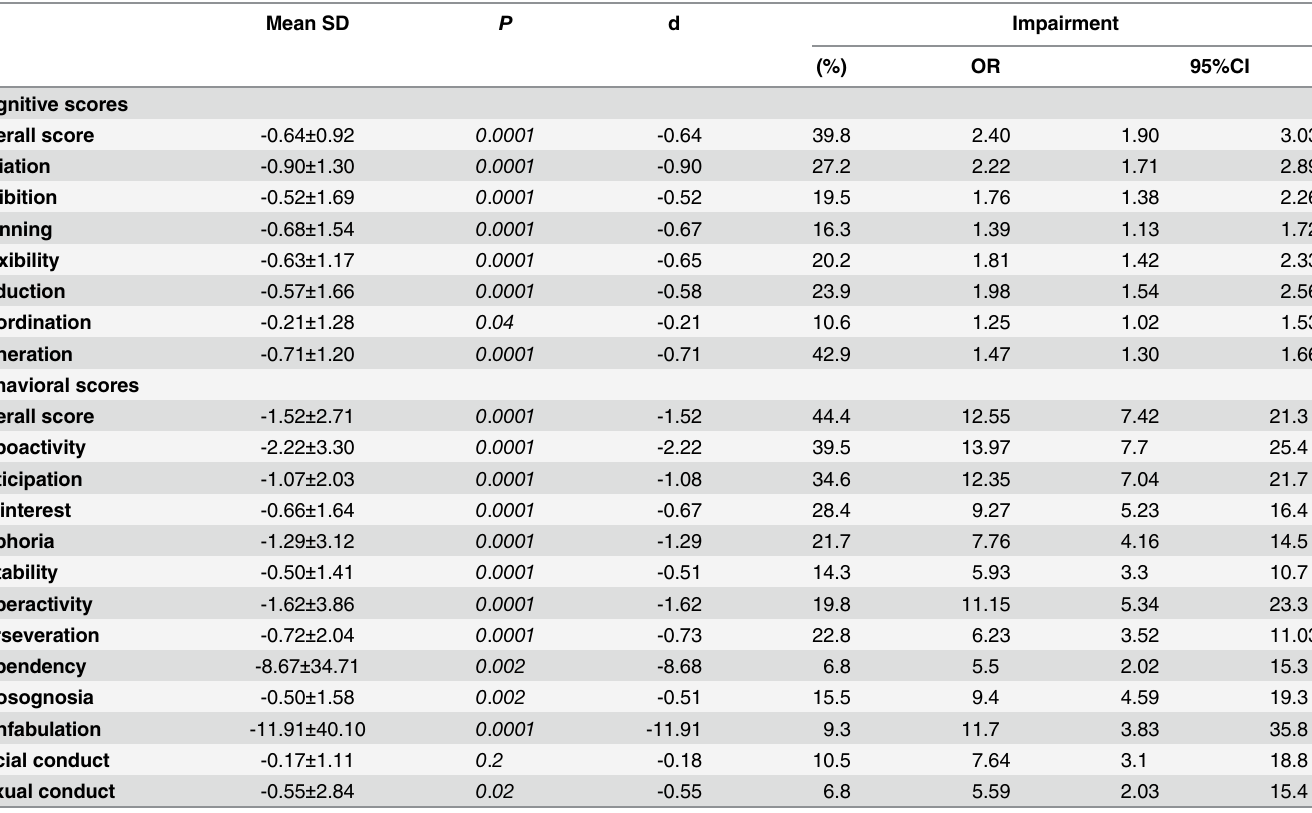
Table 3. Cognitive and behavioral executive performance expressed as mean z scores ( ± Standard Deviation (SD), effect size (d), frequency (%) of impairment and odds ratio (OR).